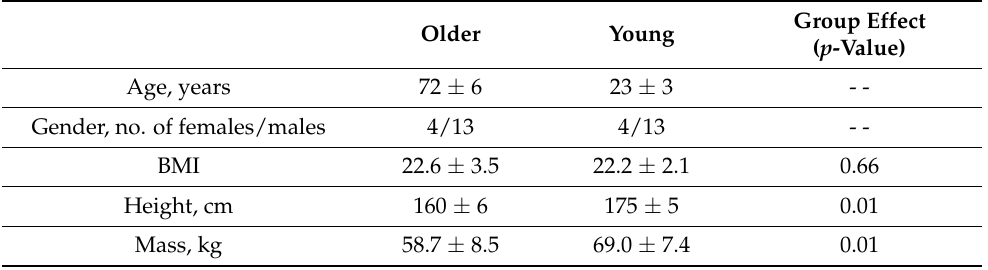
Table 1. Means (standard deviations) of the basic characteristics of older and young participants. Group Effect Older Young ( p -Value) Age, years 72 ± 6 23 ± 3 - - Gender, no. of